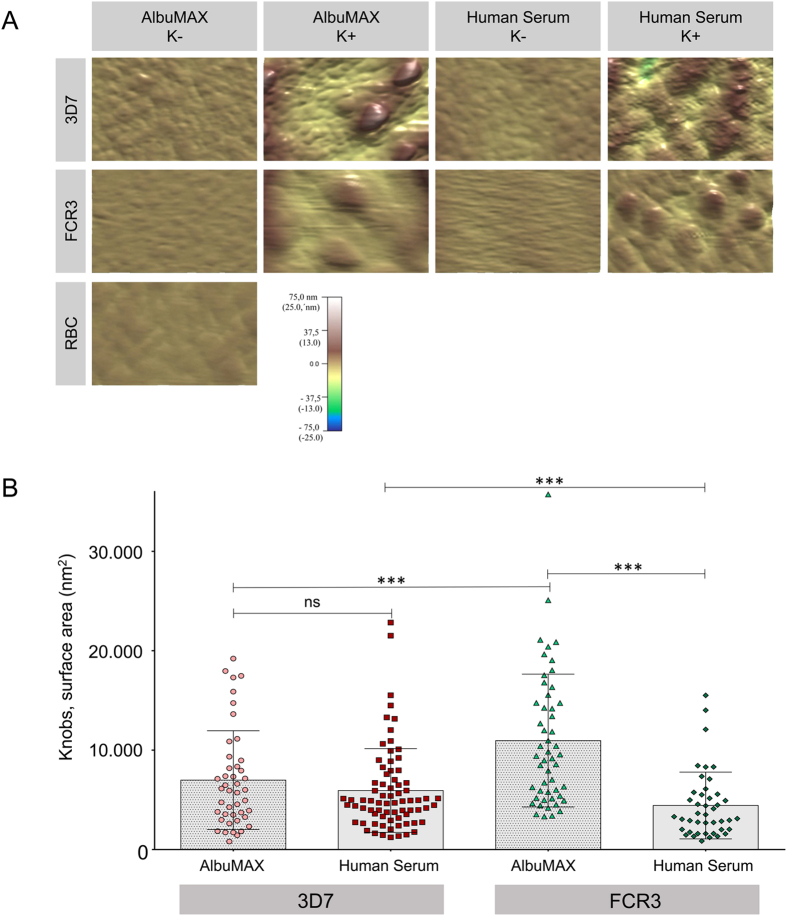
Atomic force microscopy of P. falciparum IEs.Isolates 3D7 and FCR3 were cultivated in the presence of AlbuMAX or human serum (K−). In addition, the isolates were enriched for the presence of knobs by gelatin sedimentation (K+). In each case, highly synchronized trophozoite-stage parasites (28–32 hpi) were examined. A. Scanning measurements from atomic force micrographs of 3D7 and FCR3 IEs, as well as uninfected erythrocytes (control). B. Surface area of the knobs on 3D7 and FCR3 IEs enriched for the presence of knobs. (*p ≤ 0.05, **p ≤ 0.01, ***p ≤ 0.001).